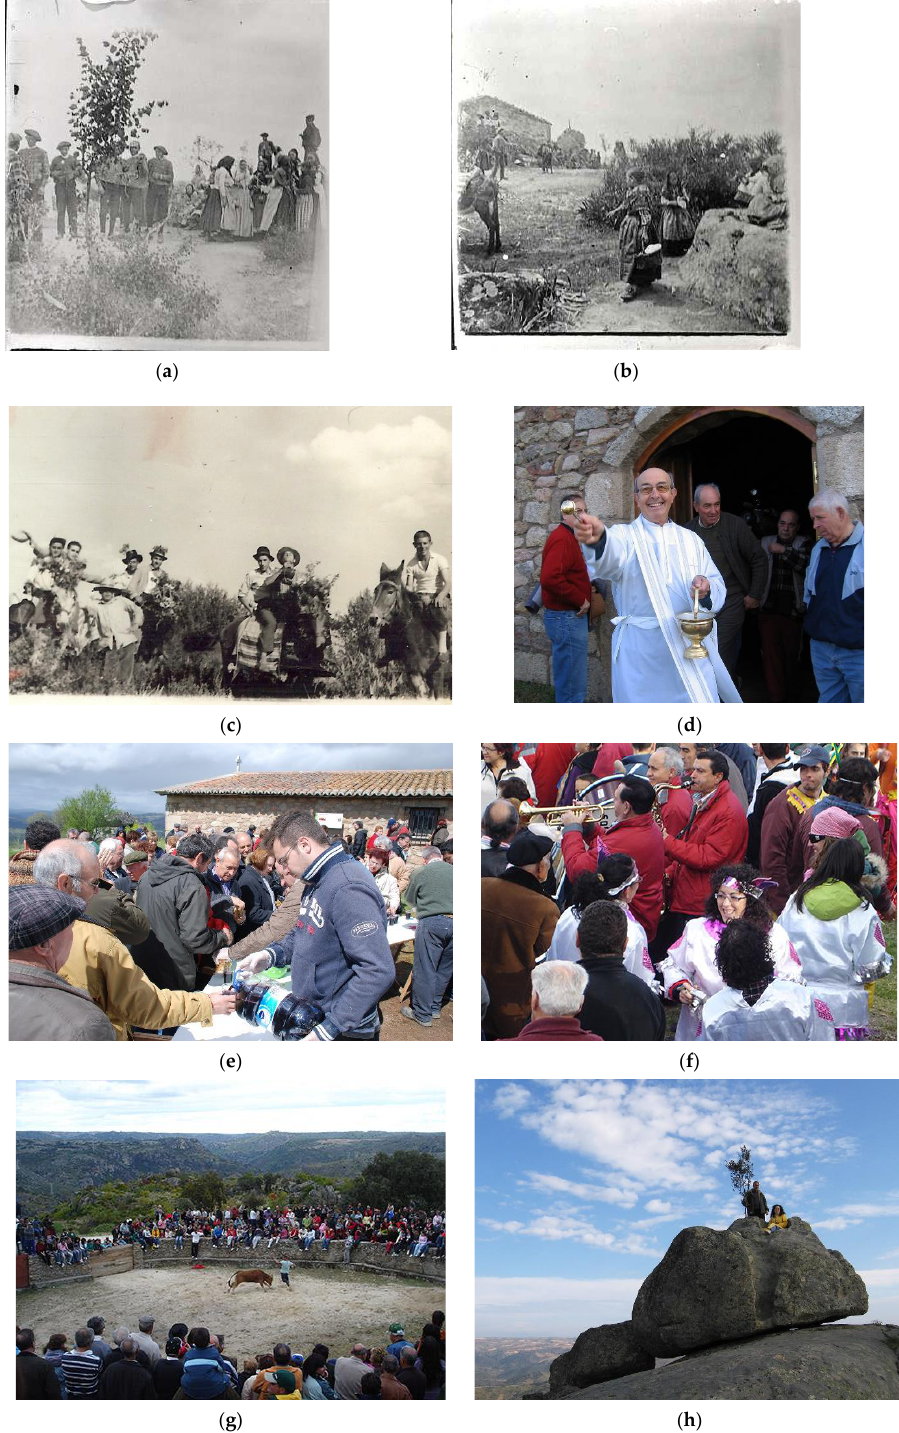
Figure 3. Different images of the celebration of the festival in the Teso de San Cristóbal (TSC) in recent history: ( a , b ) Photographs taken by Venancio Gombau in 1902 during Miguel de Unamuno’s visit to the TSC. ( c ) Around 1960, on the day of the festival, the young men adorned themselves with flowers on their hats (they even decorated their equines with flowers). ( d ) Blessing after mass at the hermitage. ( e ) At the end of the mass, the Town Council invites all the villagers to drink sangria, and eat olives and chochos (pickled lupini beans). ( f ) The younger villagers dance to the sound of the charanga band. ( g ) For some years, on this day of popular celebration, a couple of heifers fought in the bullring at the TSC. ( h ) Peña del Pendón, located on the highest point of the hill and facing east – west. On its east side, there are carved steps leading to the top, where there is a series of hollows (“thrones”) and a hole where traditionally the banner has been placed (photos by J.A. González).